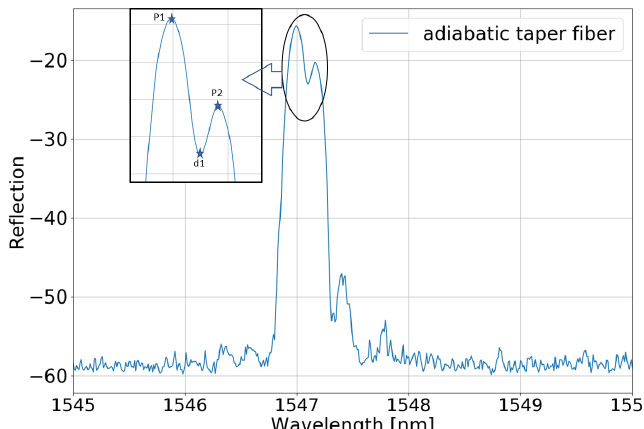
Figure 9. Spectrum of the fabricated FP in adiabatic fiber